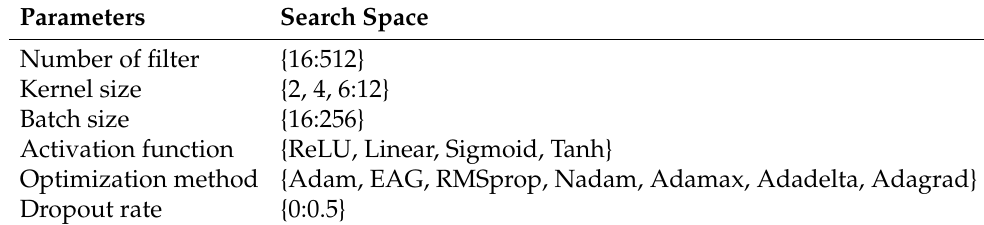
Table 2. Hyperparameters search space.